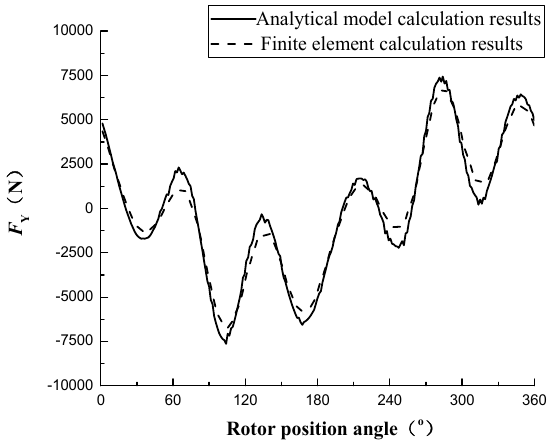
Figure 11. The X -axis unbalanced magnetic pull (UMP) of rotor in fault.